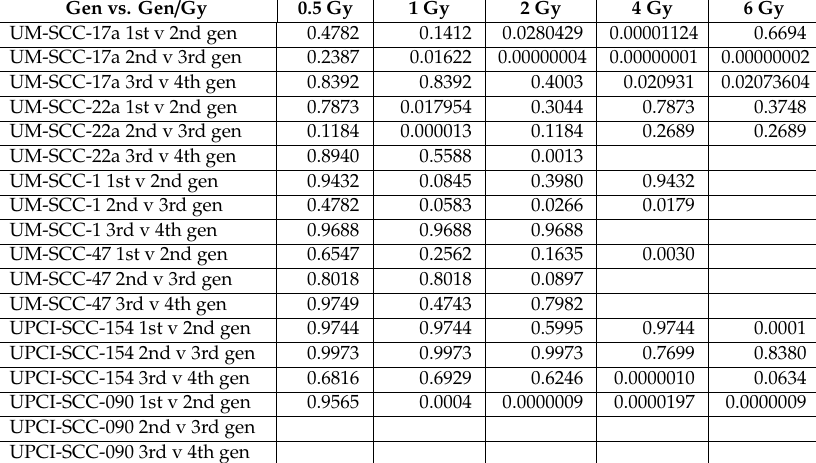
Table A1. Significance of intergenerational change in SF. Change in SF between consecutive generations for dose. p -value by multiple t test. Red figures denote